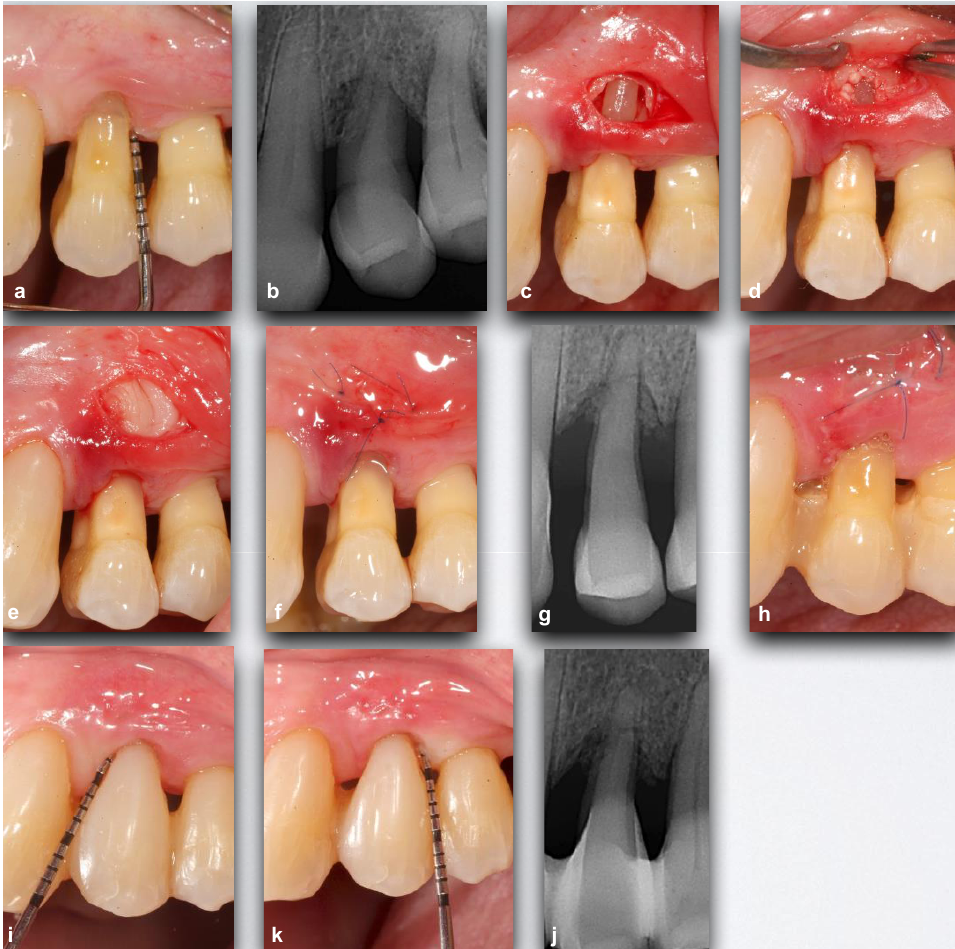
Figure 1. Case 24. ( a , b ) Upper left first premolar with advanced periodontal destruction and grade II mobility with two mesial and distal intra-bone defects. ( c ) Apical incision exposing intrabony defects and lack of vestibular cortical plates. ( d , e ) Biomaterials and adapted platelet and leukocyte-rich fibrin (L-PRF) membrane. ( f , g ) Suture and post-surgical X-ray. ( h ) Closure at the first attempt seven days post-surgery. ( i – k ) 12 months after surgery. A composite restoration was performed for aesthetic reasons. Significant reduction in probing pocket depth (PPD) and healthy soft tissues with acceptable scalloping. X-ray: resolution of intrabony defects.